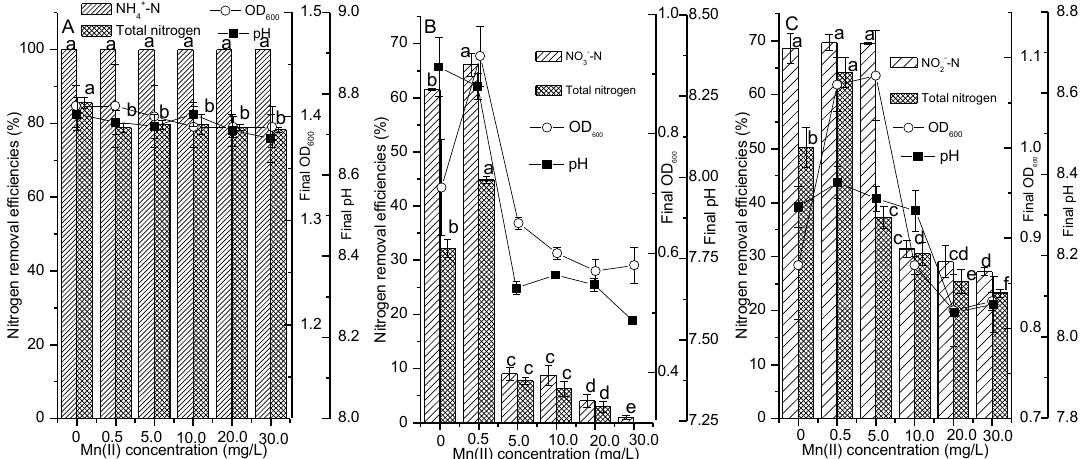
Figure 3. Effects of Mn(II) on ammonium, nitrate, and nitrite removal abilities of strain Y-10. ( A ) ammonium; ( B ) nitrate; ( C ) nitrite. The values shown are the means ± the SD of the results of three replicates (error bars). Different letters indicate a significant difference between treatments at p < 0.05.